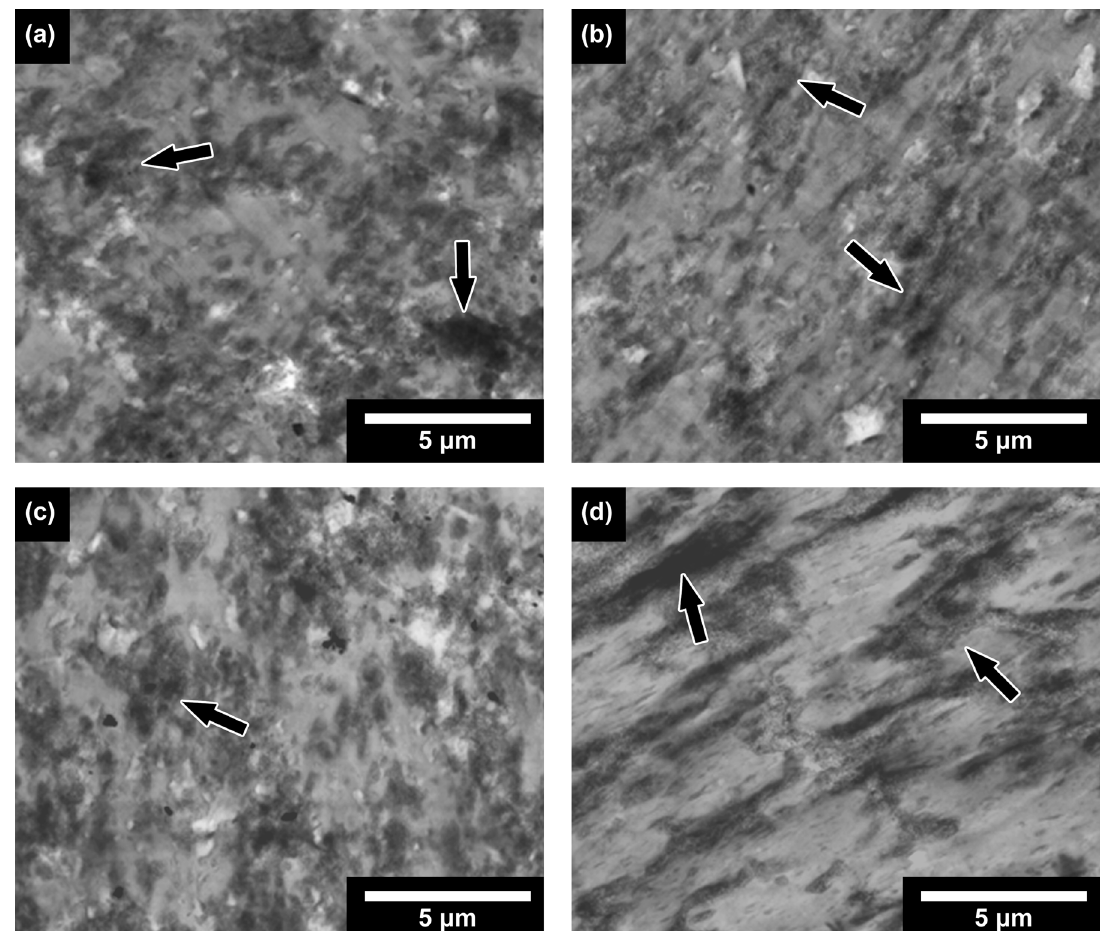
Figure 5. Low-magnification TEM micrographs of (a) PA6/AES; (b) PA6/AES/MMA-MA3%; (c) PA6/AES/MMA-MA5% and (d) PA6/ AES/MMA-MA10%. Table 4. Thermomechanical and mechanical properties of PA6; PA6/AES and blends compatibilized with MMA-MA synthetized with different MA contents.